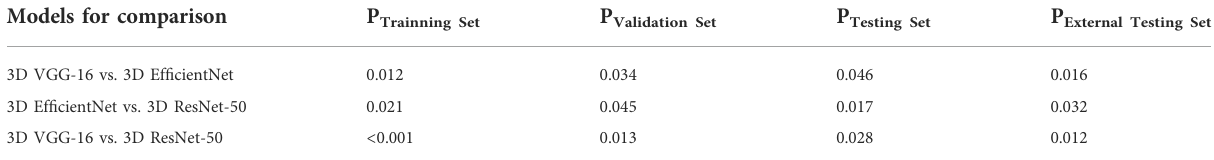
TABLE 3 Comparison of 3 different deep learning models on the training, validation, testing and external testing sets. Models for comparison